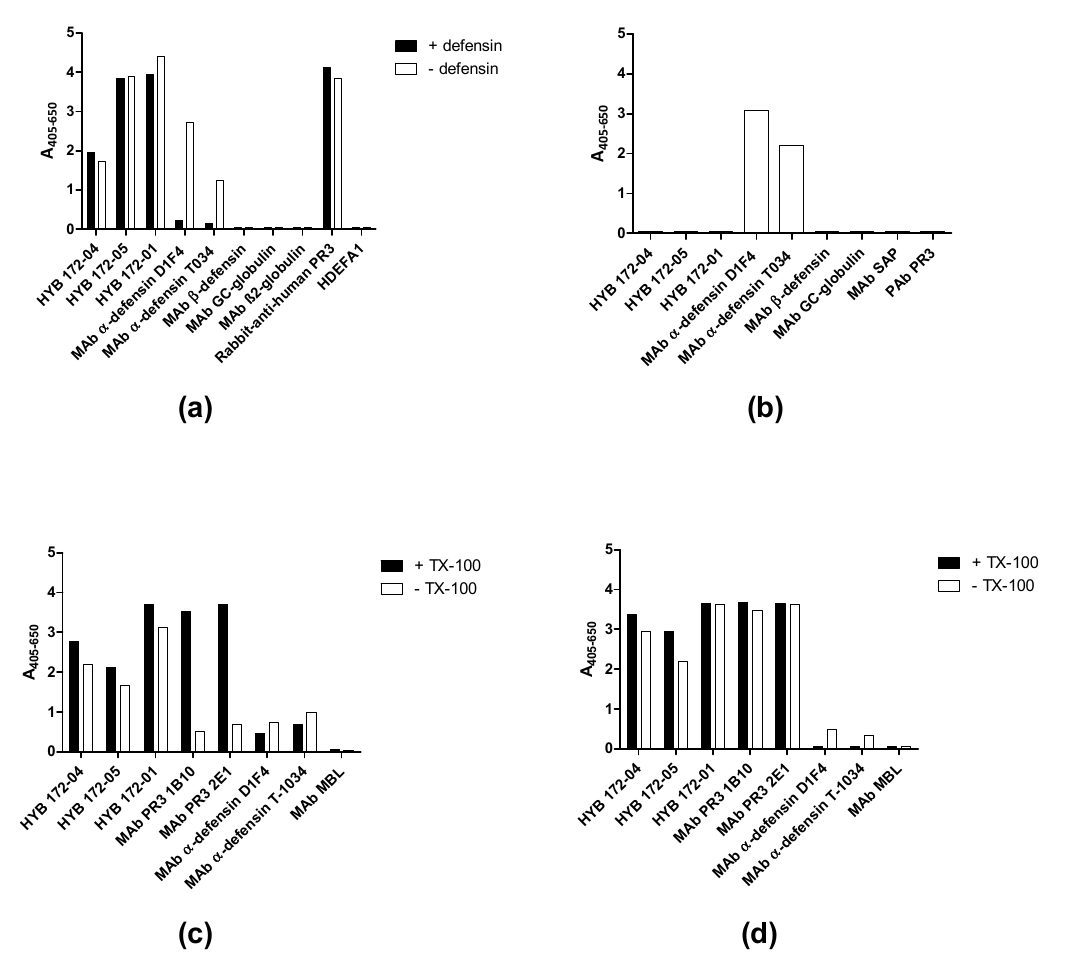
Figure 3. MAb binding to PR3 analysed by ELISA. ( a ) Binding of MAbs to SSI PR3 with or without addition of defensins. ( b ) MAb binding to coated defensins. ( c ) MAb binding to Wieslab PR3 coated with or without Triton X-100 (TX-100). ( d ) MAb binding to Arotec PR3 coated in the absence or presence of Triton X-100.